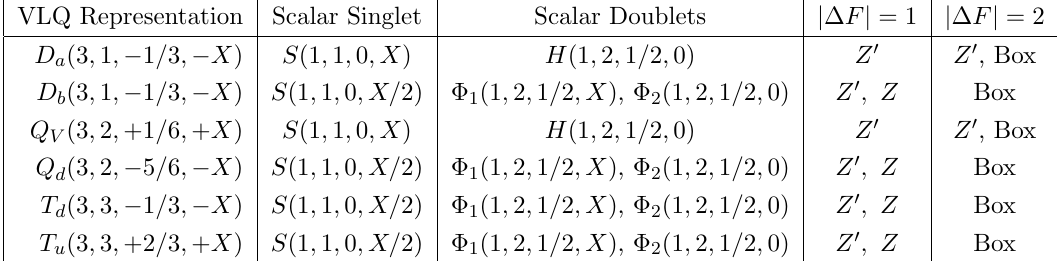
SU(2) L U(1) Y U(1) L in G 0 - SM (cid:22) (cid:0) L (cid:28) (cid:10) (cid:10) (cid:10) (cid:1) F = 1 j j